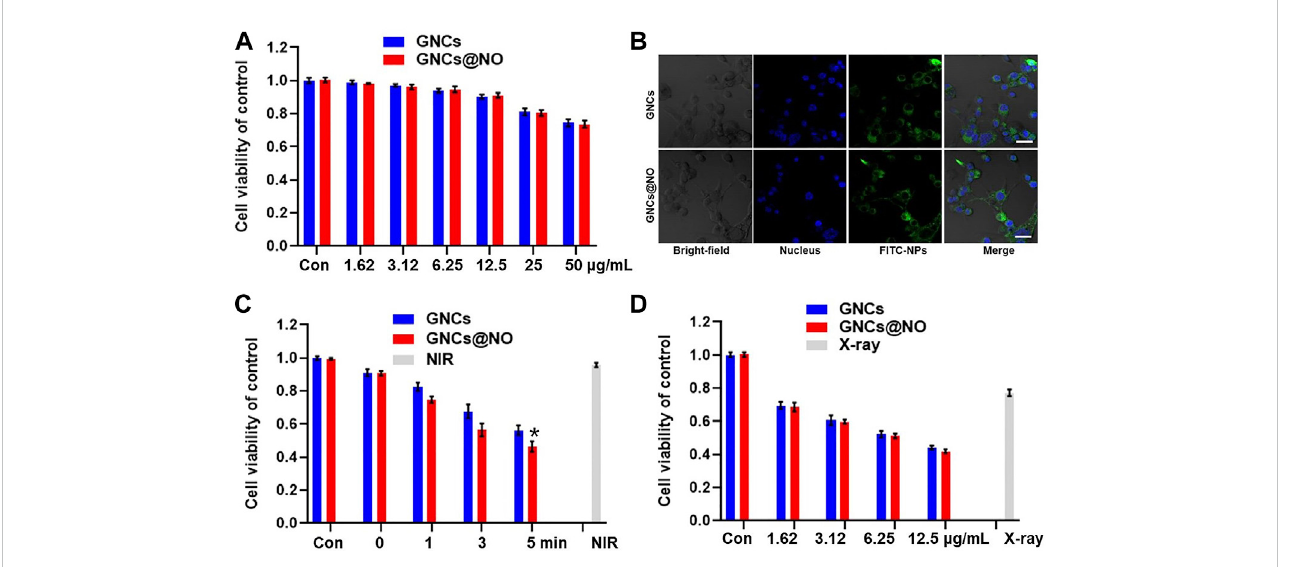
FIGURE 2 Photothermal therapy and radiosensitization of GNCs@NO. (A) Cytotoxicity of GNCs and GNCs@NO at various concentrations in MCF-7 cells. (B) CLSM imagesofMCF-7cellsco-incubatedwithGNCsorGNCs@NOfor3h.Scalebar=10 μ m. (C) ViabilityofMCF-7cellsafterincubationwithGNCsorGNCs@NO with NIR irradiation. * p < 0.05 versus GNC group. (D) Viability ofMCF-7cells after incubation with GNCsor GNCs@NO with exposure to X-ray irradiation.The values represent mean values ±SD, n = 5.